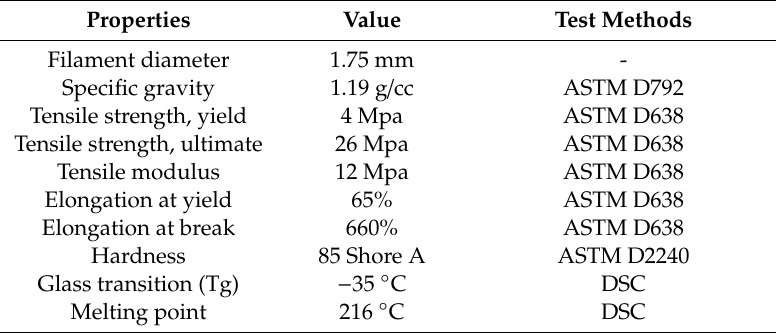
Table 2. Specifications of thermoplastic polyurethane (TPU) filament.